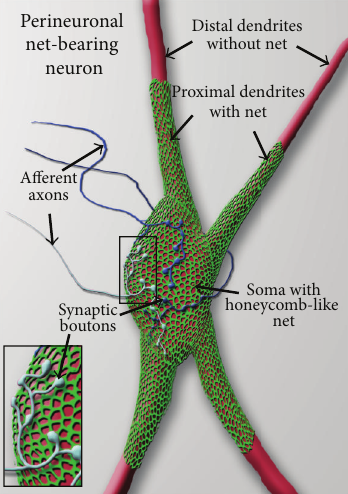
Figure 1: Schematic view of a perineuronal net-bearing neuron. A neuronal cell body (soma) with its proximal dendrites (red) covered by a typical reticular, honeycomb like net (green). More distally, dendrites are devoid of nets. The holes in the perineuronal nets are occupied by synaptic boutons of afferent axons (insert, blue) that synapse on the net-bearing